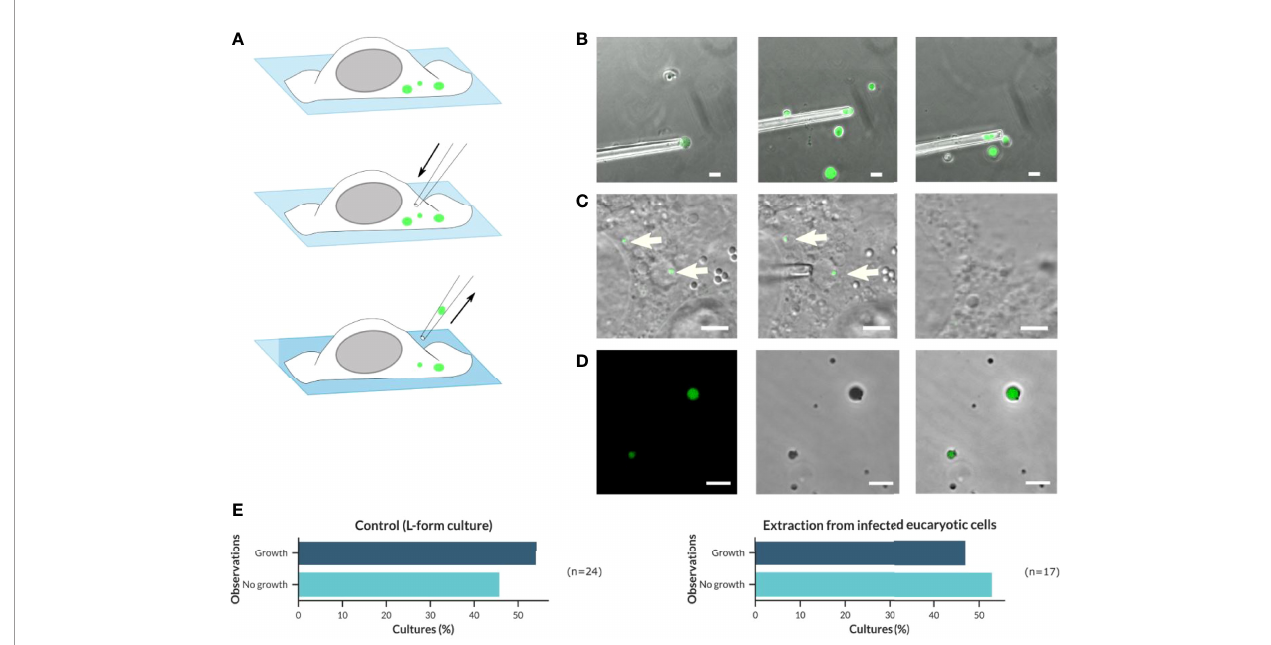
FIGURE 6 | Application of a micromanipulator to isolate and transfer intracellular Listeria L-forms from infected host cells to fresh culture medium in order to demonstrate their viability and ability to grow. (A) Schematic overview about the procedure of micromanipulator extraction and transfer of intracellular GFP- fl uorescent Listeria monocytogenes L-forms. (B) Proof of concept for extraction and transfer of L. monocytogenes Rev10-GFP L-forms from a pure culture to fresh medium using micromanipulation (Scale bar = 10 µm). (C) Extraction and transfer of intracellular L. monocytogenes Rev10 GFP-expressing L-forms from infected BeWo cells (Scale bar = 5 µm). (D) Growth of L. monocytogenes Rev10 GFP-expressing L-forms after transfer to fresh culture tubes (DM3 medium withoutAmpicillin) andincubation for upto three weeks at 32°C was con fi rmed byconfocallaser scanning microscopy (CLSM) (Scalebar = 10 µm). (E) Graphical distribution of the proportion of L. monocytogenes Rev10 L-forms growingafter micromanipulatorextraction of L-formcells frompurecultures (left) or BeWo cells